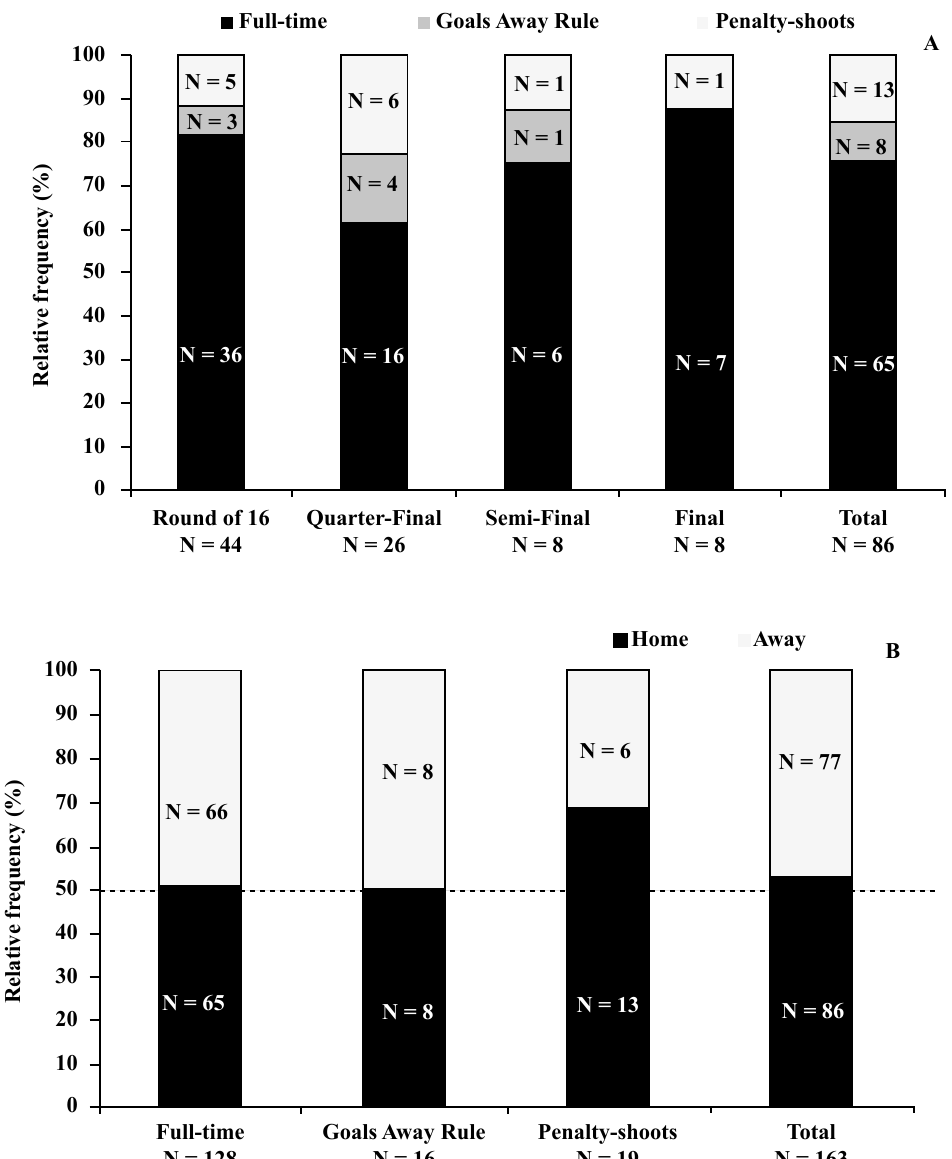
Figure 3. Second-leg home advantage occurring through all win forms (full-time, goals away rule and penalty shoot-outs) during the round of 16, quarterfinal, semi-final, final and total (Panel A), and the second-leg home advantage of all matches defined as binomial “HOME” or “AWAY” results according to full-time, goals away rule and penalty shoot-outs win forms (Panel